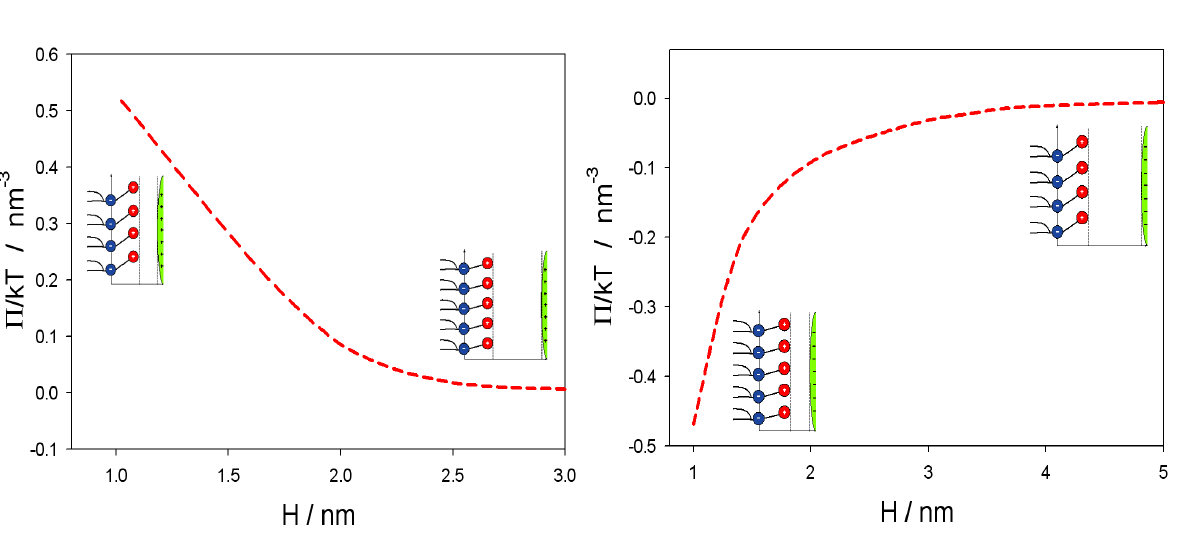
Osmotic pressure between the plane of the phosphate groups of dipolar (zwitterionic) headgroups and the surface of positively ( left panel) and negatively ( right panel) charged nanoparticle, as a function of the distance ( H ) (see, also, Figures 4 and 5) =N = 0 : 01 mol = L , by using calculated for (cid:11) = 5 and the bulk concentration of salt, n 0 A Equation (9). The values of other model parameters are the same as in Figure